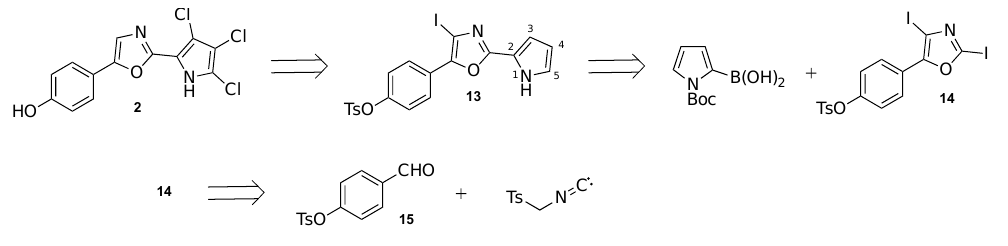
Scheme 1. Retrosynthetic analysis for 2 .